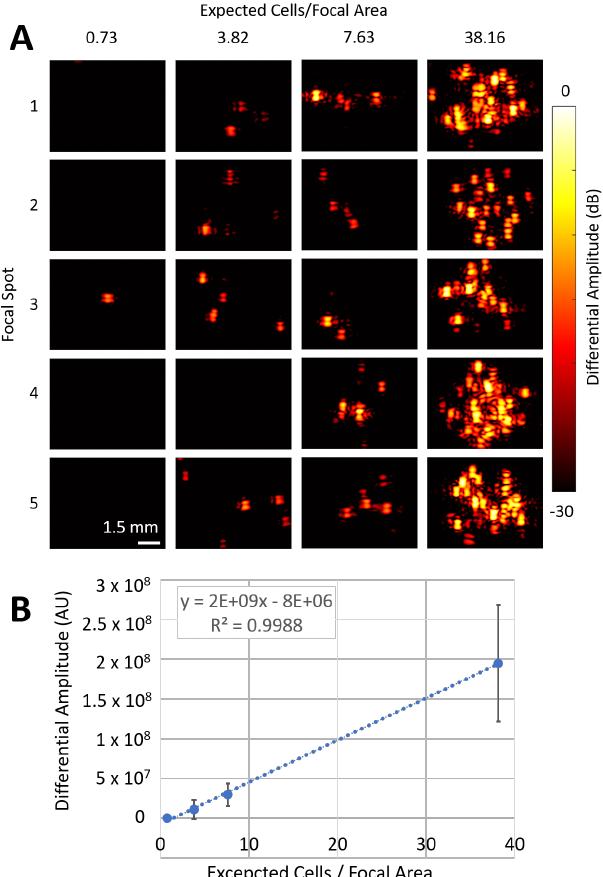
Figure 7. Cells with PFHnD-Abs attached to them were diluted to different concentrations and embedded into polyacrylamide phantoms. ( A ) Images of the differential ultrasound amplitude for each of the different concentrations. The expected cells/focal area was calculated based on the initial concentration of cells. ( B ) The differential amplitude plotted as a function of the expected cells/focal area yielded an r 2 of